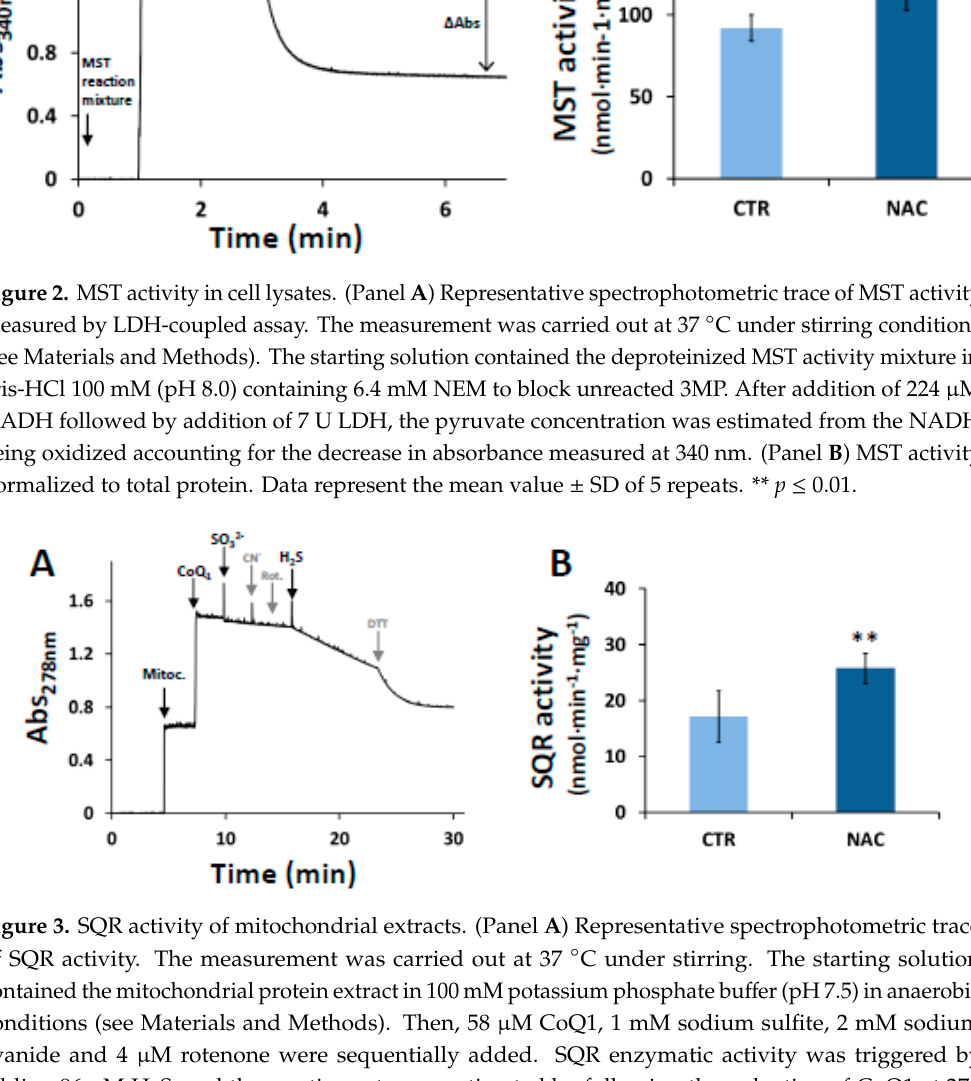
Figure 2. MST activity in cell lysates. (Panel A ) Representative spectrophotometric trace of MST activity measured by LDH-coupled assay. The measurement was carried out at 37 °C under stirring conditions (see Materials and Methods). The starting solution contained the deproteinized MST activity mixture in Tris-HCl 100 mM (pH 8.0) containing 6.4 mM NEM to block unreacted 3MP. After addition of 224 μ M NADH followed by addition of 7 U LDH, the pyruvate concentration was estimated from the NADH being oxidized accounting for the decrease in absorbance measured at 340 nm. (Panel B ) MST activity normalized to total protein. Data represent the mean value ± SD of 5 repeats. ** p ≤ 0.01.